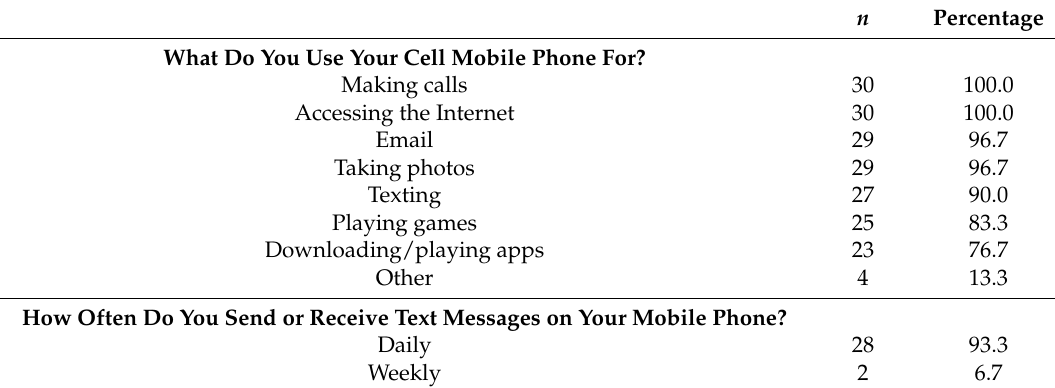
Table 1. Descriptive statistics for cell phone usage ( n = 30).